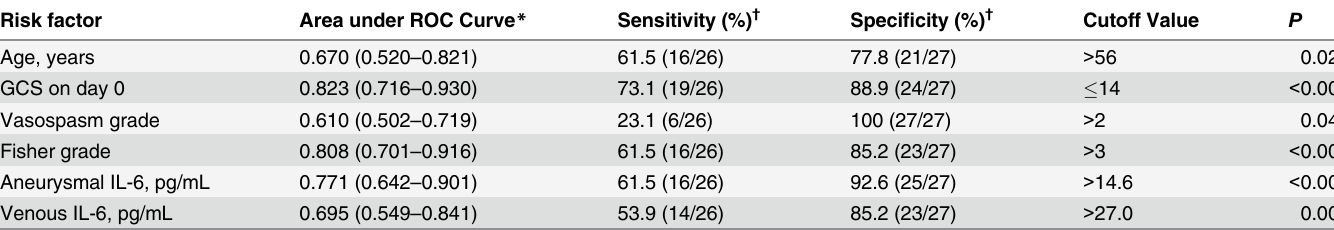
Table 3. ROC analyses of the risk factors for predicting 30-day outcome. Risk factor